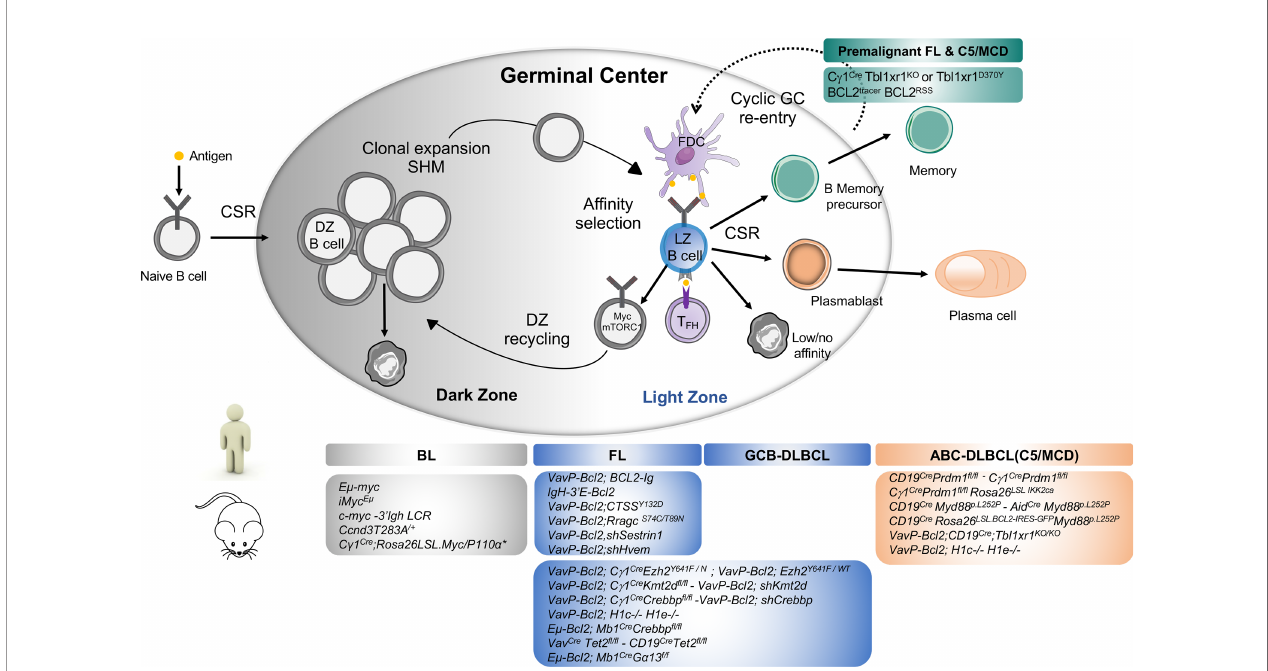
FIGURE 1 | Major mouse models of human B cell lymphomas linked to their putative normal B cell counterpart. Top Panel: Schematic representation of Germinal Center B cells. Activated B cells enter in the GC dark zone (DZ), the site of clonal expansion and somatic hypermutation. Only a subset of DZ B cells will be selected to pass in the GC light zone (LZ) while most DZ B cells undergo apoptosis. GC LZ is the site of af fi nity-based selection where high-af fi nity B cells tend to capture more antigen from FDC and receive more T cell help through CD40/CD40L interaction driving their re-entry into the DZ for de fi ned rounds of proliferation and